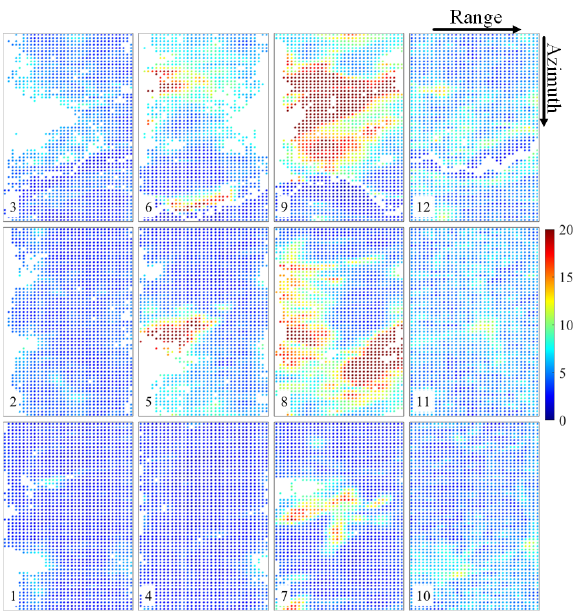
Figure 11. The distribution and slope of the CSs in slant–range coordinates; the color represents the slopes of the CSs. The numbers in the lower left corner are the image